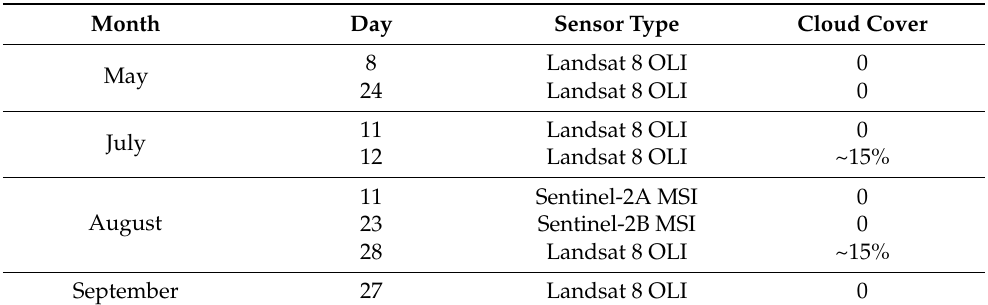
Table 1. Availability of Landsat 8 and Sentinel-2A/2B satellite images over the study area during the growing season of 2018.